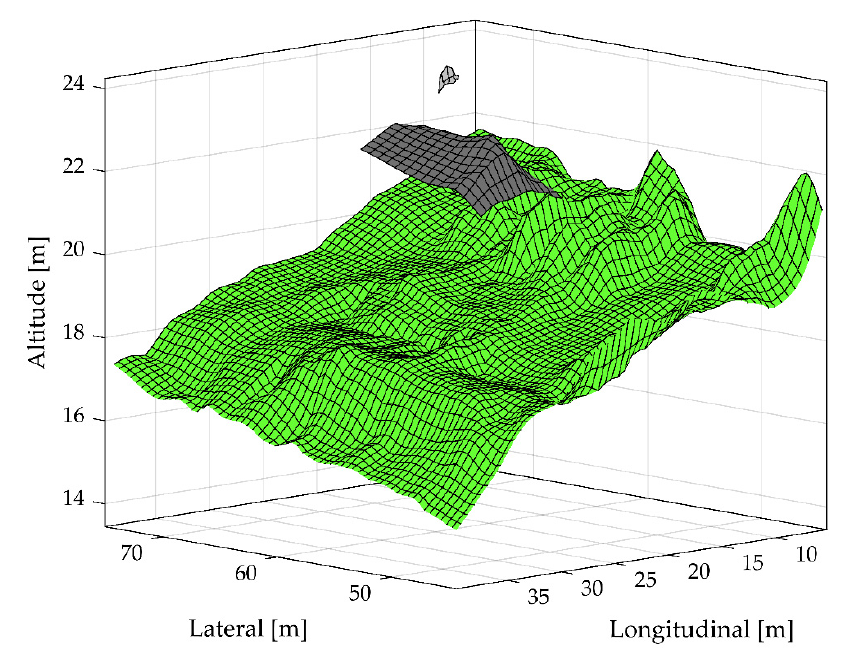
Figure 7. Reconstruction of the building after the complete processing pipeline. The ground is represented in green, the rooftop of the building in grey and the top of the chimney in silver.